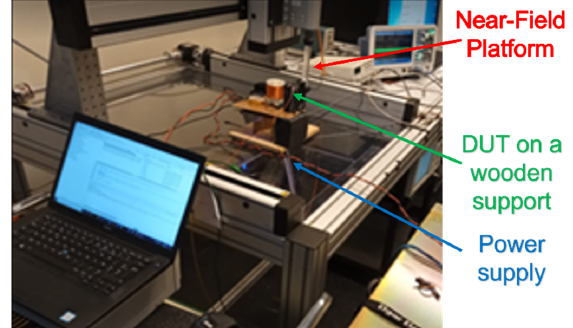
Figure 10. DUT under test with the closed field test bench.